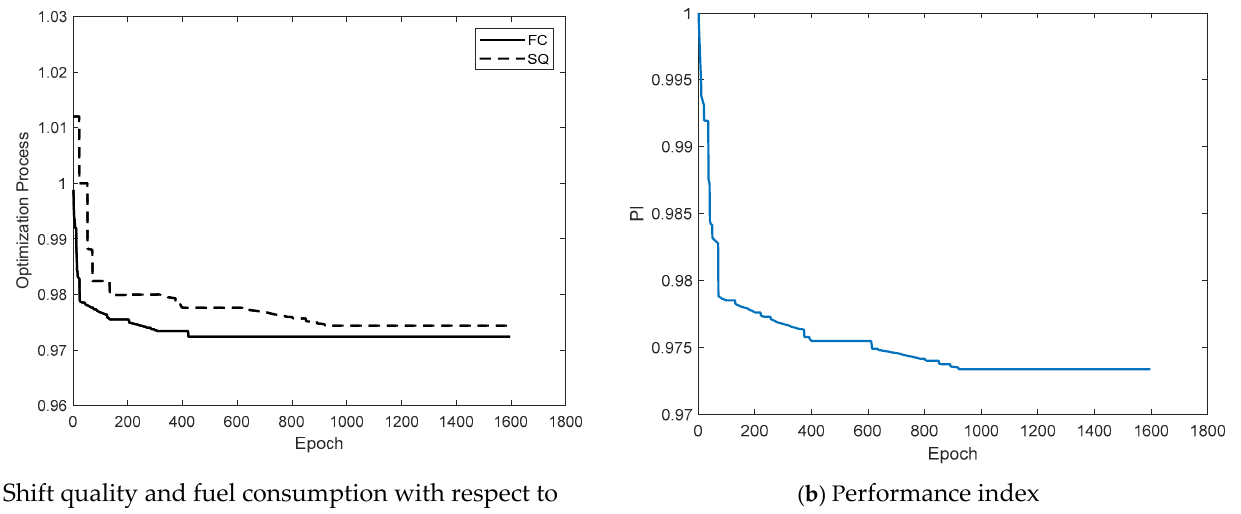
Figure 8. Example of calibration process of an aggressive driver. ( a ) Shift quality and fuel consumption in the calibration process; ( b ) Performance index in the calibration process.